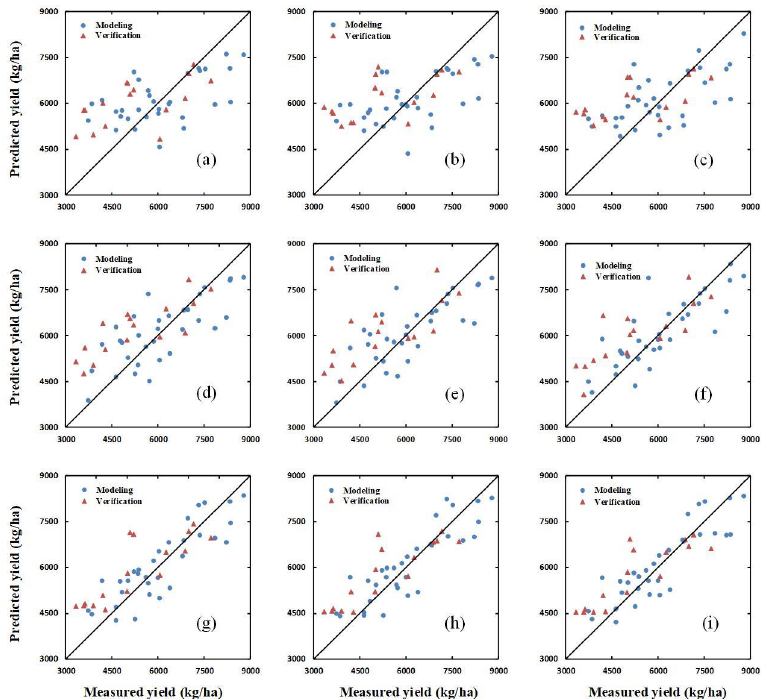
Figure 6. The relationships between the ground-measured and predicted values of winter-wheat yield at different growth stages based on partial least squares regression (PLSR). ( a ), ( b ), and ( c ) show the results for SIs, a combination of SIs and H, and a combination of SIs and H CSM , respectively, at the jointing stage. ( d ), ( e ), and ( f ) show the same as ( a ), ( b ), and ( c ) for the flagging stage; and ( g ), ( h ), and ( i ) show the same as ( a ), ( b ), and ( c ) for the flowering stage.